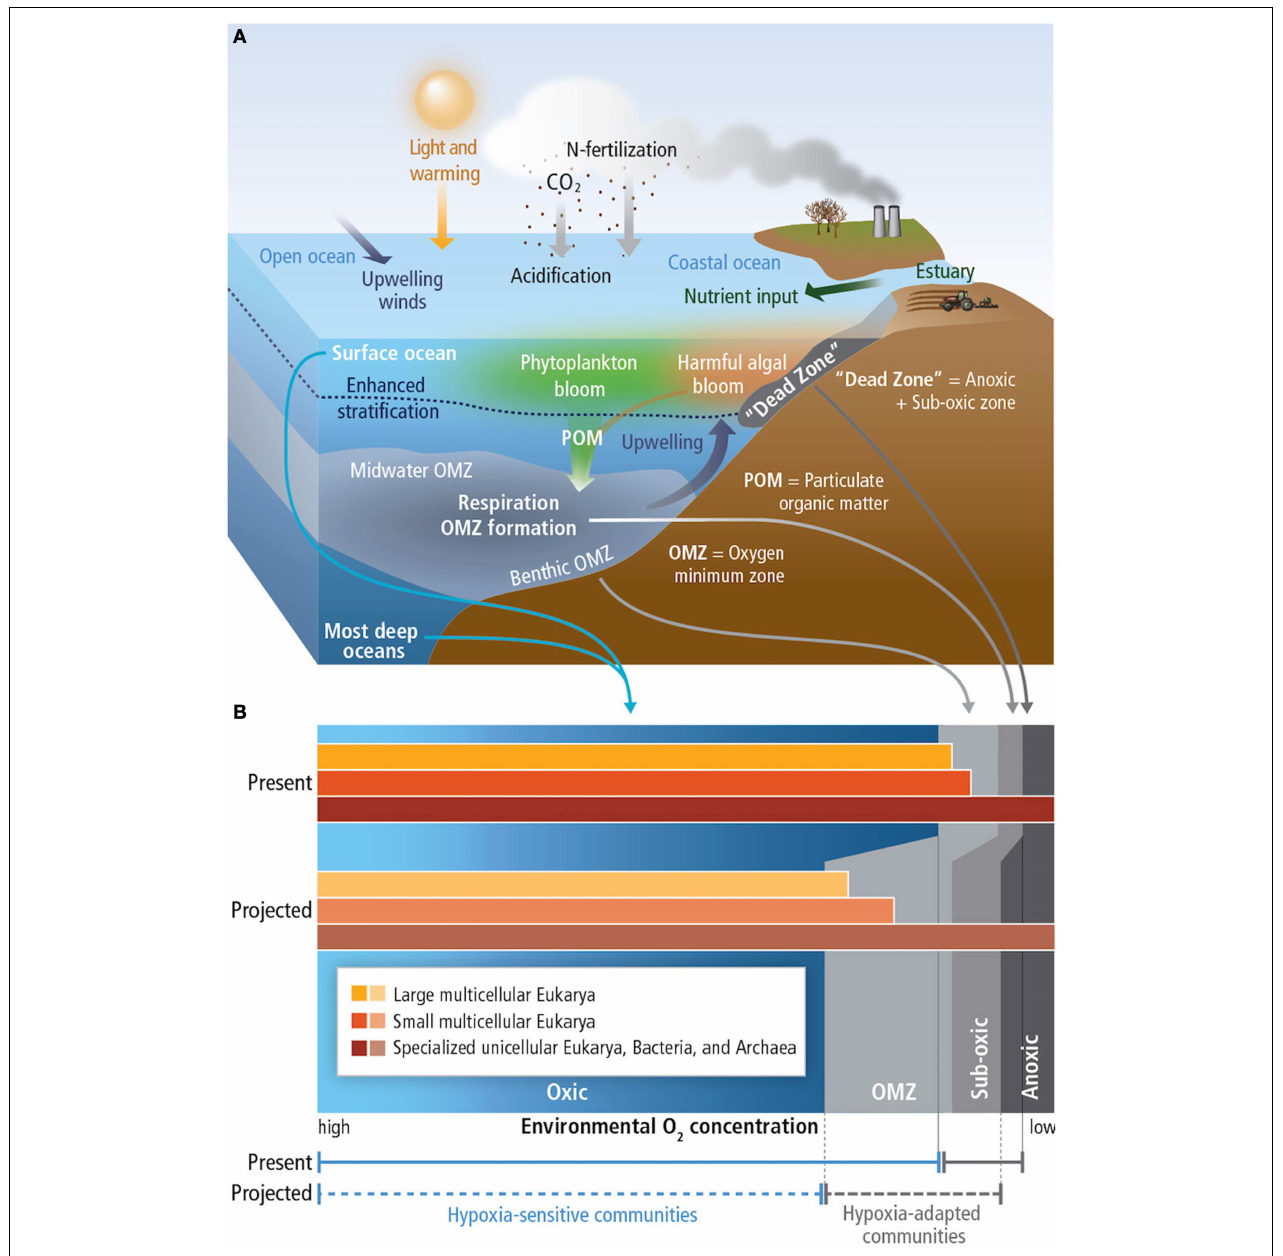
FIGURE 4 | (A) Principal mechanisms underlying the formation of hypoxic conditions and their biological background. The buoyant, fresh input from rivers produces sharp density stratification at the base of the freshened layer (also valid for ice melt and high precipitation) near the surface and, hence, vertical mixing is greatly reduced. In consequence, the nutrient inputs from the river and the atmosphere accumulate in a narrow upper layer, leading to blooms of phytoplankton. The increased oxygen consumption due to aerobic decomposition of sinking particulate organic matter (POM) results in hypoxic conditions of benthic and mid-water oxygen minimum zones